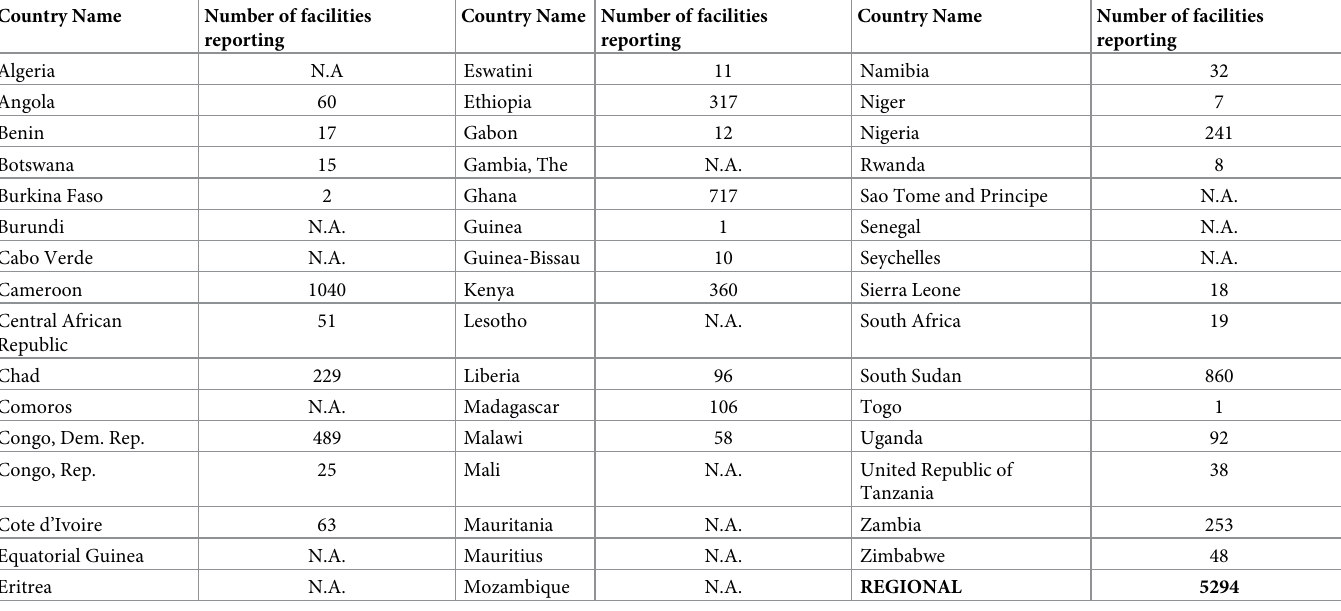
Table 2. Number of health facilities assessing their inherent system resilience by country, December 2019–March